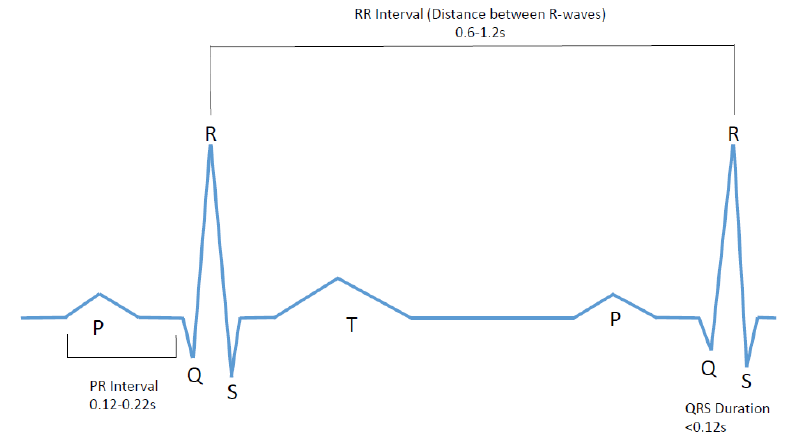
Figure 1. Normal electrocardiogram (ECG) signal with wave durations and intervals.